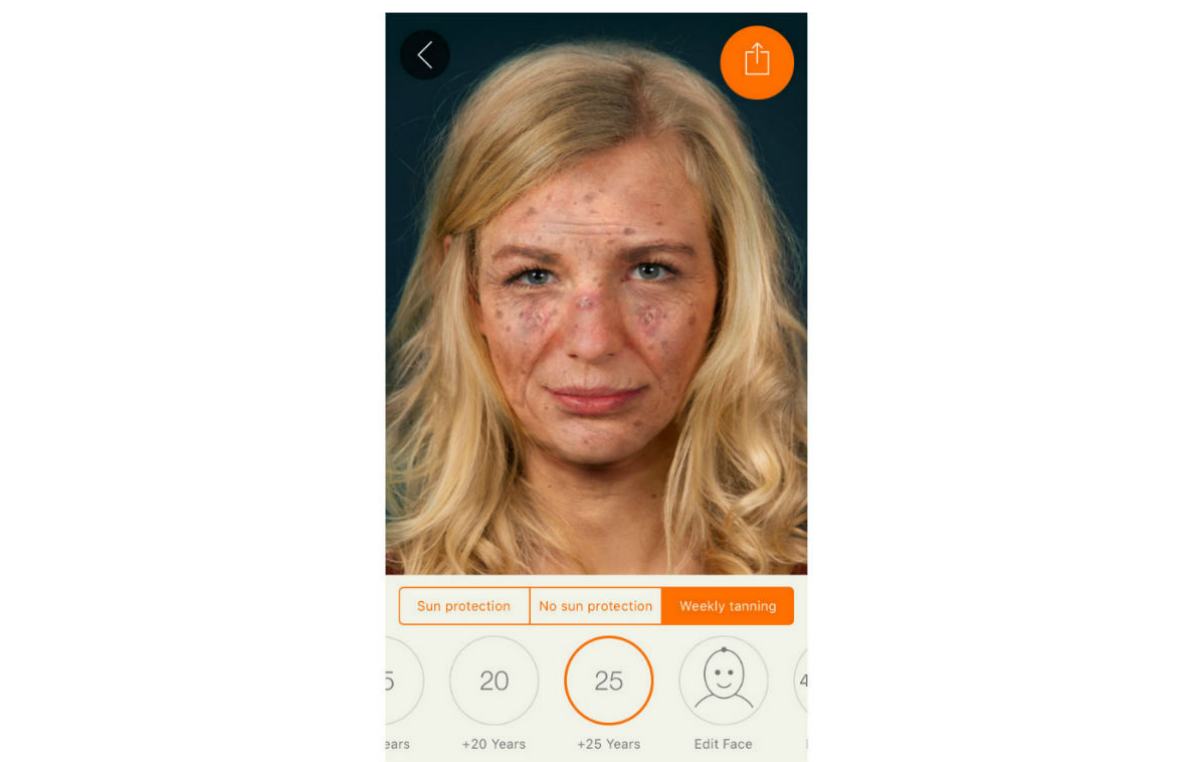
Figure 4. Maximum effect view: 25 years of UV damage due to weekly